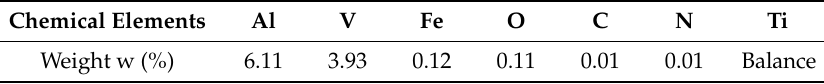
Table 1. Nominal chemical composition of Ti6Al4V ELI